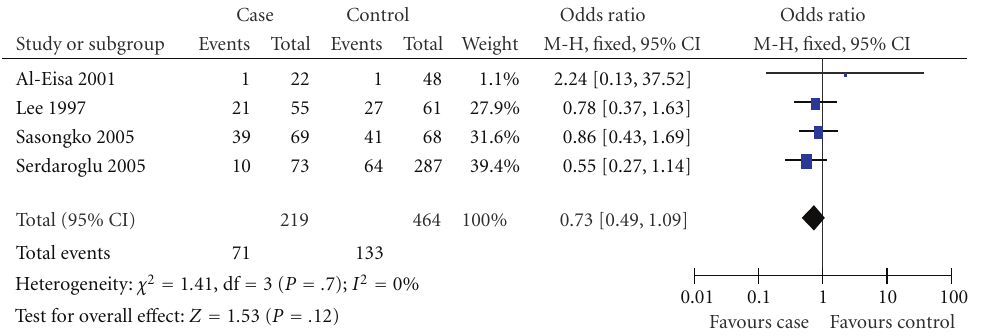
Figure 3: Association between II homozygous and risk of MCNS in